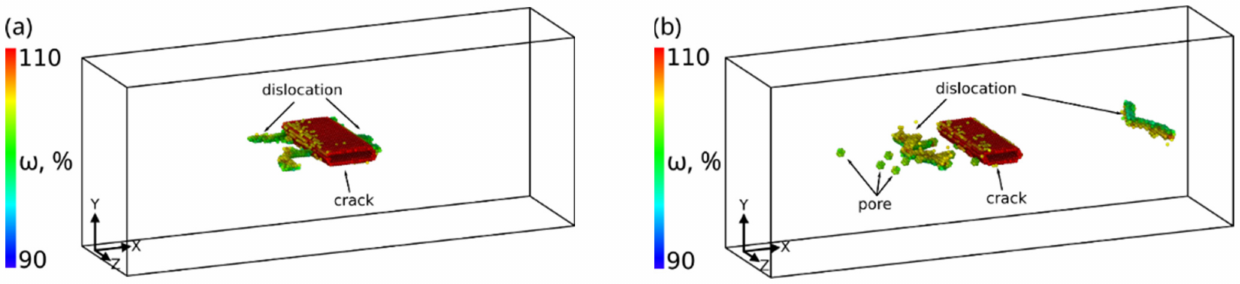
Figure 8. Defect structure at 6.3% ( a ) and 12.4% ( b ) shear deformation for sample with (112)[110] crack. Bcc atoms with volume <105% are not shown.